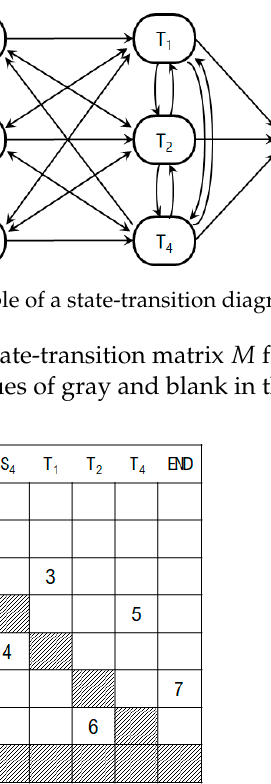
Figure 3. An example of a sparse state-transition matrix 𝑀 .